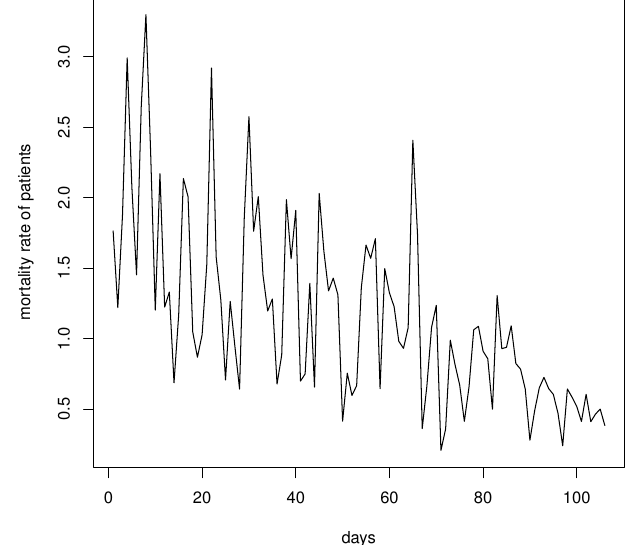
Figure 9. Trend of mortality rate data taken from Mexico.